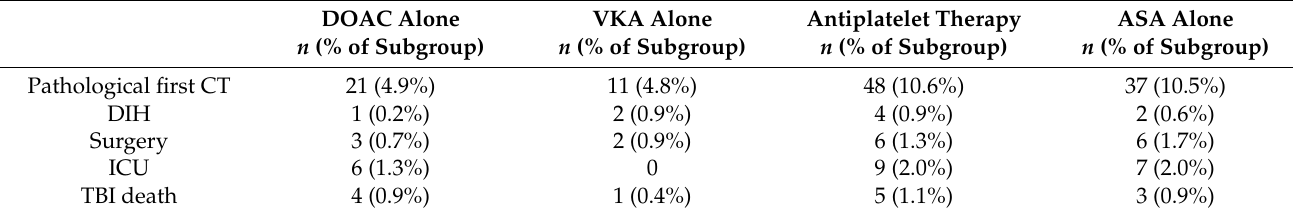
Table 2. Results of outcome parameters in the subgroups. For statistical purposes, the groups consist of DOAC alone without other ATT combination therapies, VKA alone without combination therapies, all types of antiplatelet therapy including dual therapy and ASA